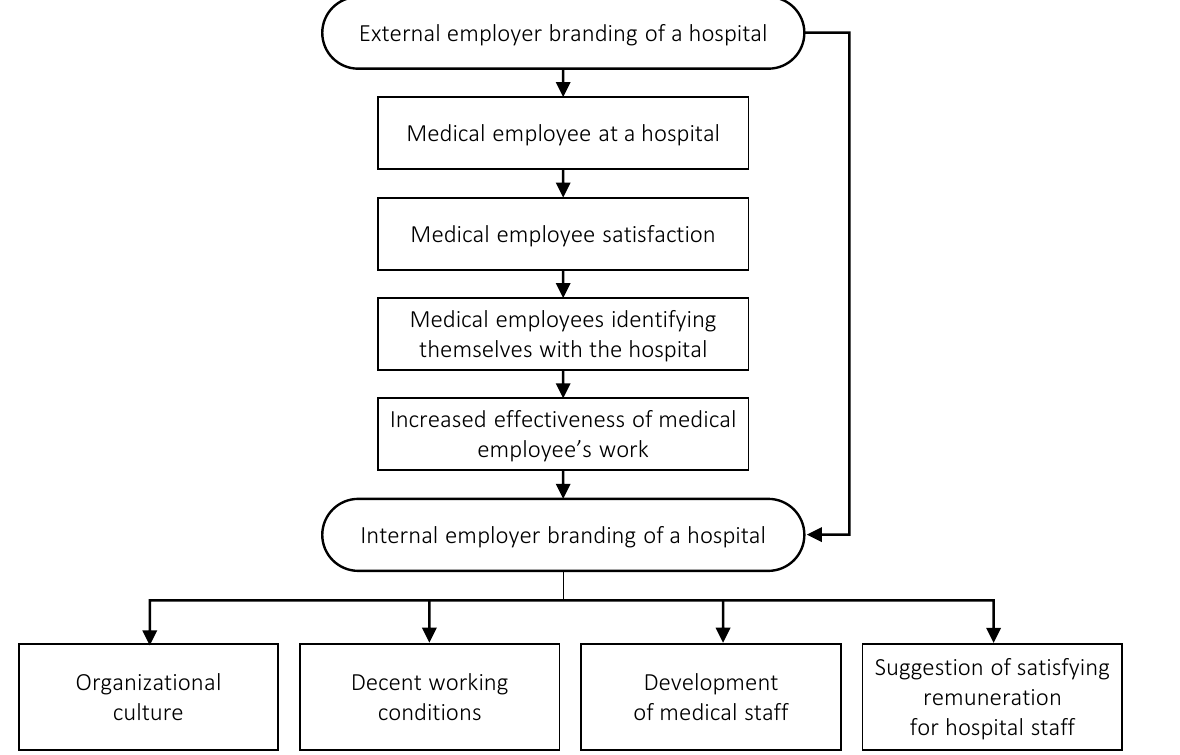
Figure 3. Diagram presenting the influence of internal employer branding on a